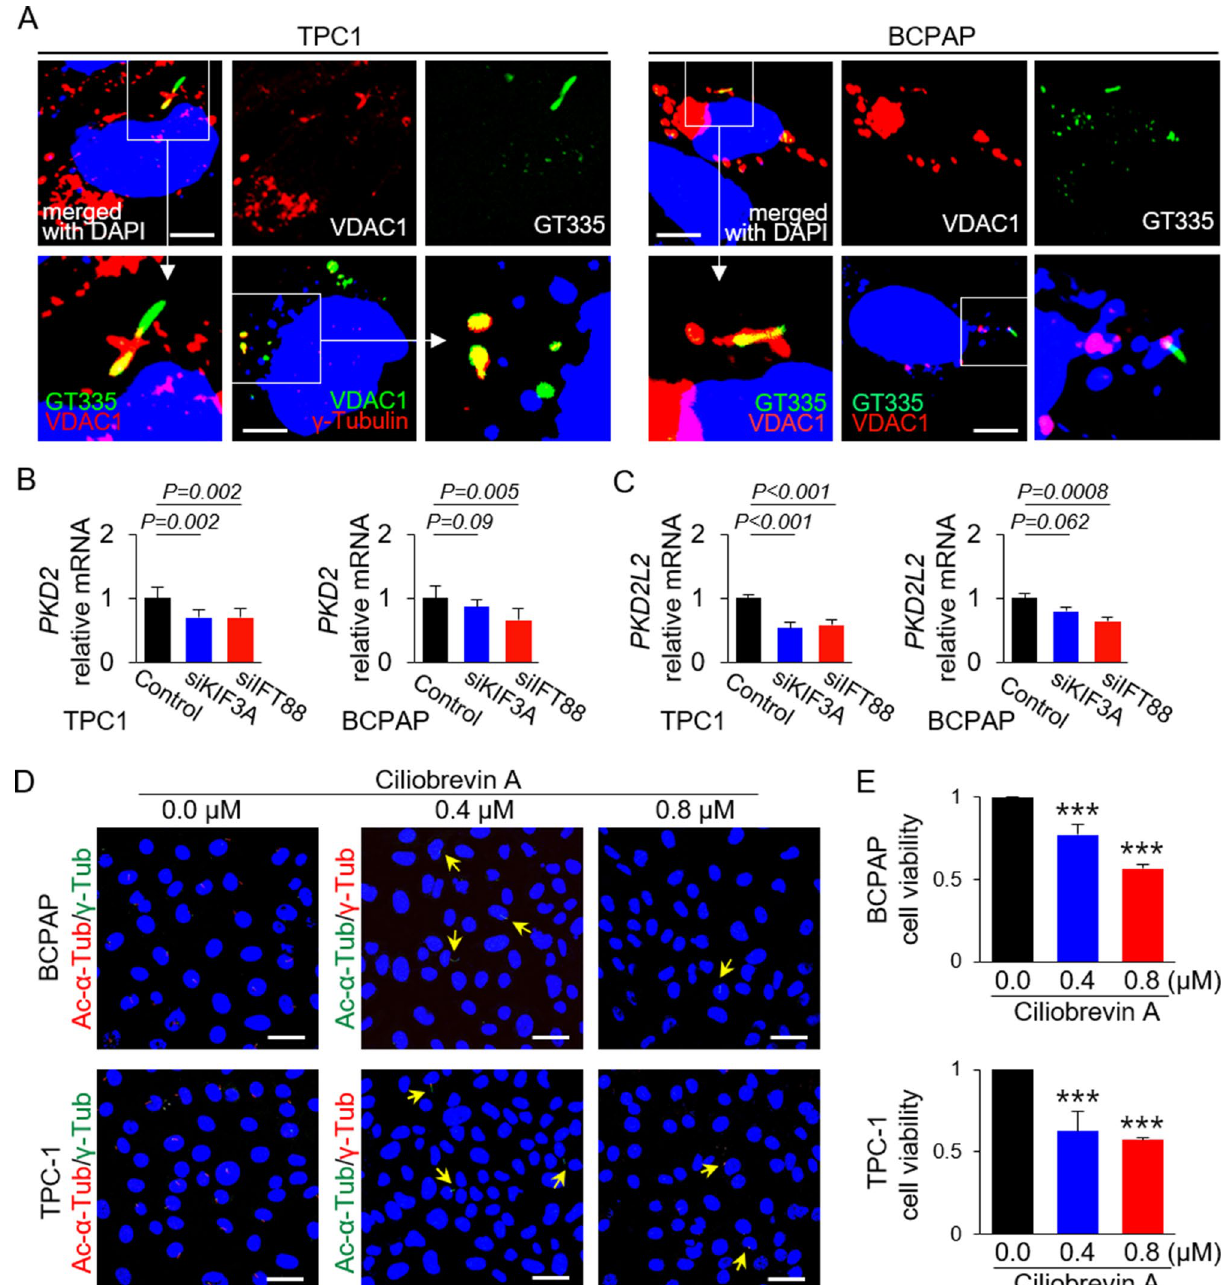
Figure 5. Extramitochondrial VDAC1 is localized in the basal body of primary cilia in PTC cells. ( A ) Immunofluorescence images show that VDAC1 localized to the basal body of primary cilia in thyroid cancer cell lines. Primary cilia were stained by anti-GT335 antibody (axonemes with basal bodies) and anti-γ-tubulin (basal bodies) antibodies. Scale bar, 10 μm. ( B , C ) Expression of PKD2 and PKD2L2 mRNA in KIF3A -deficient or IFT88 -deficient thyroid cancer cell lines (TPC1 and BCPAP) compared with that in negative control siRNA-transfected cells. ( D ) BCPAP and TPC1 were incubated for 36 h with 0.4 μM or 0.8 μM ciliobrevin A. Immunofluorescence images show primary cilia stained with anti-acetylated-α-tubulin and anti-γ-tubulin antibodies. In the ciliobrevin A-treated groups, primary cilia are indicated by arrows. Scale bar, 10 μm. ( E ) The viability of BCPAP and TPC1 was evaluated in an EZ-cytox cell viability assay. Cell viability in the ciliobrevin A-treated groups was significantly lower than that in the untreated groups. *** P <